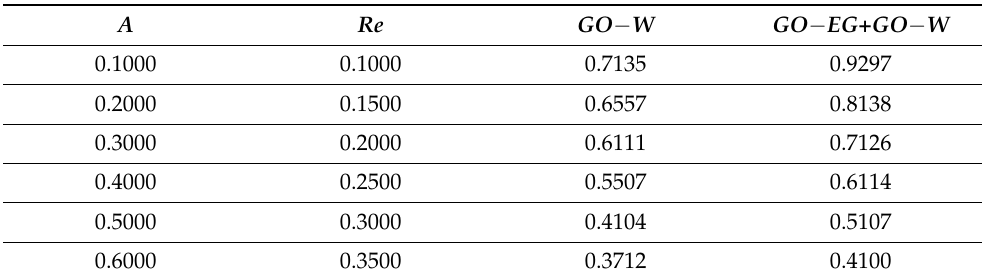
Table 3. Evaluation of the suction parameter and Reynolds number on the skin friction coefficient.